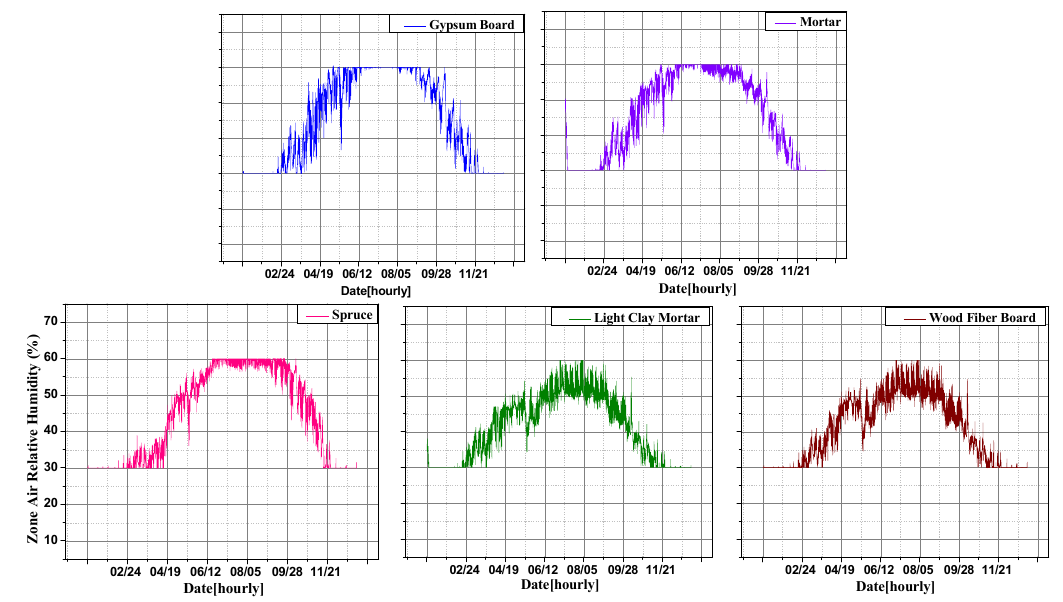
Figure 6. Indoor RH under central air conditioning control.